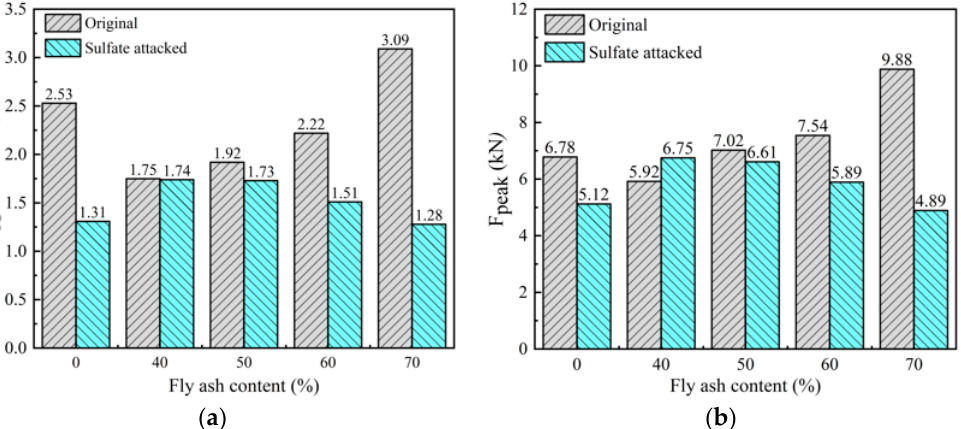
Figure 6. Fracture toughness and of SFSCC before and after dry–wet cycle sulfate attack. ( a ) Fracture toughness. ( b ) Peak load. toughness. ( b ) Peak